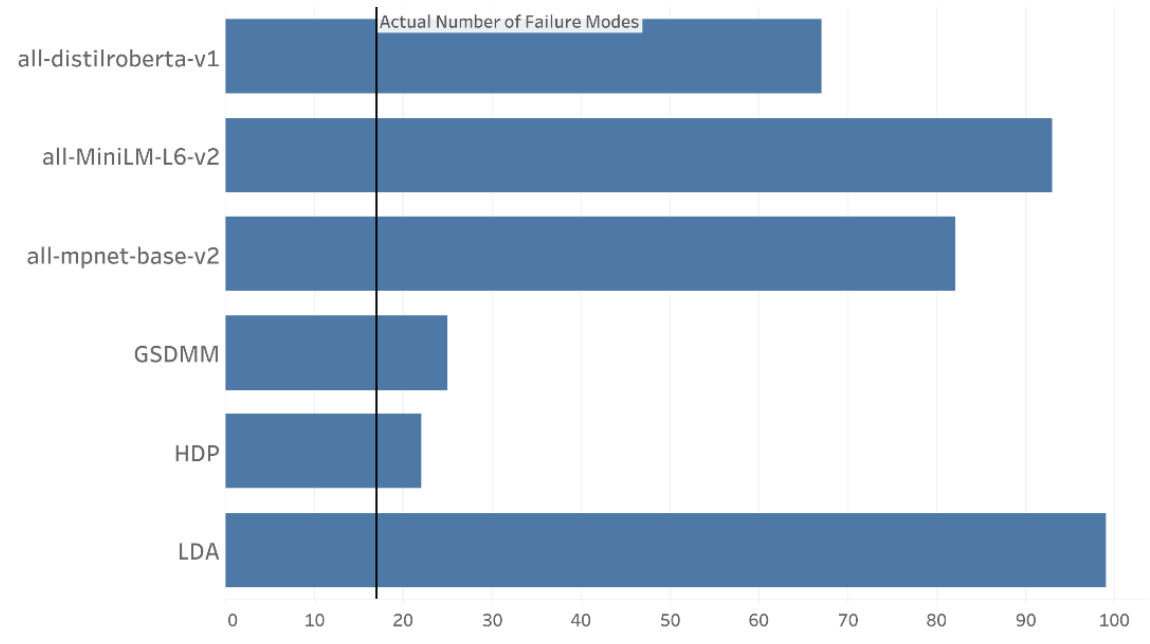
Figure 10. Number of Topics Discovered.